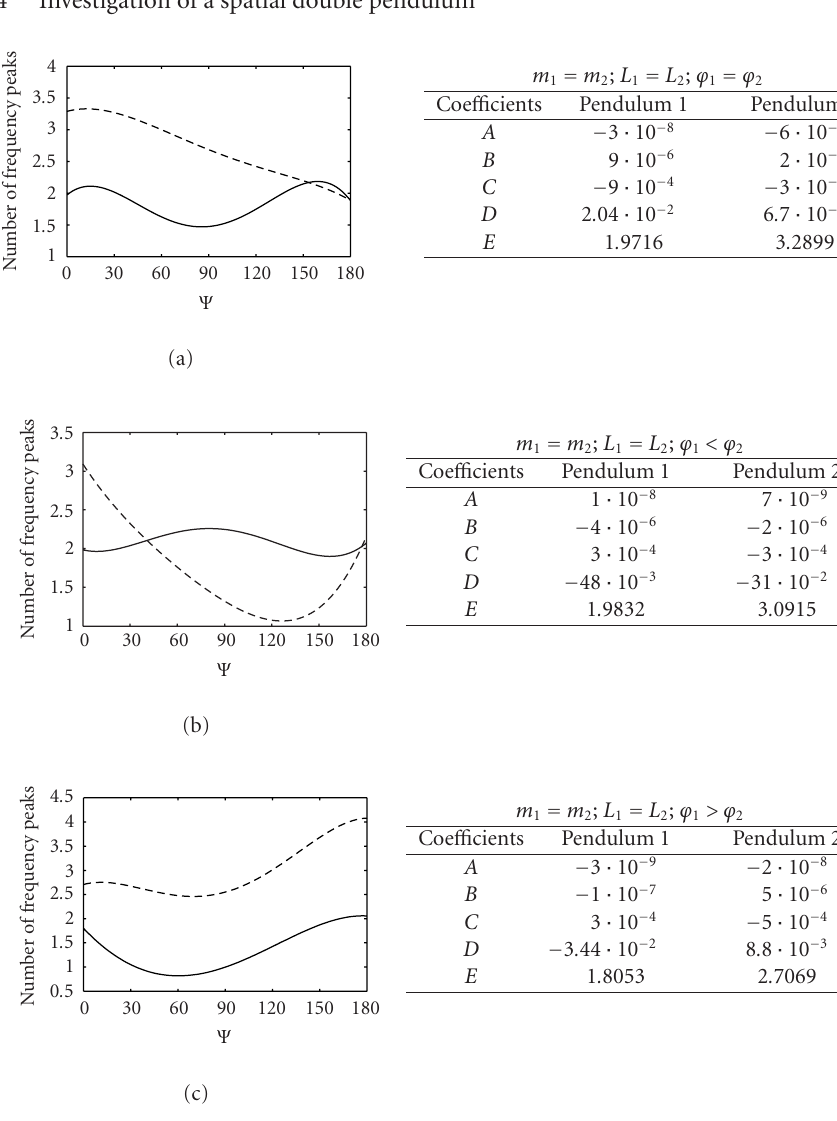
Figure 4.1. Peak distribution curves for pendulums (PDCP) for the cases in which m 1 = m 2 where 0.5 kg < m 1 < 4kg and L 1 = L 2 where 0.1 m < L 1 < 5m for: (a) ϕ 1 = ϕ 2 where 5 ◦ < ϕ 1 < 40 ◦ ; (b) 2 ϕ 1 < ϕ 2 < 6 ϕ 1 where 2 ◦ < ϕ 1 < 15 ◦ ; and (c) 2 ϕ 2 < ϕ 1 < 6 ϕ 2 where 2 ◦ < ϕ 2 < 15 ◦ . Solid curve is PDCP of pendulum 1, and doted curve is PDCP of pendulum